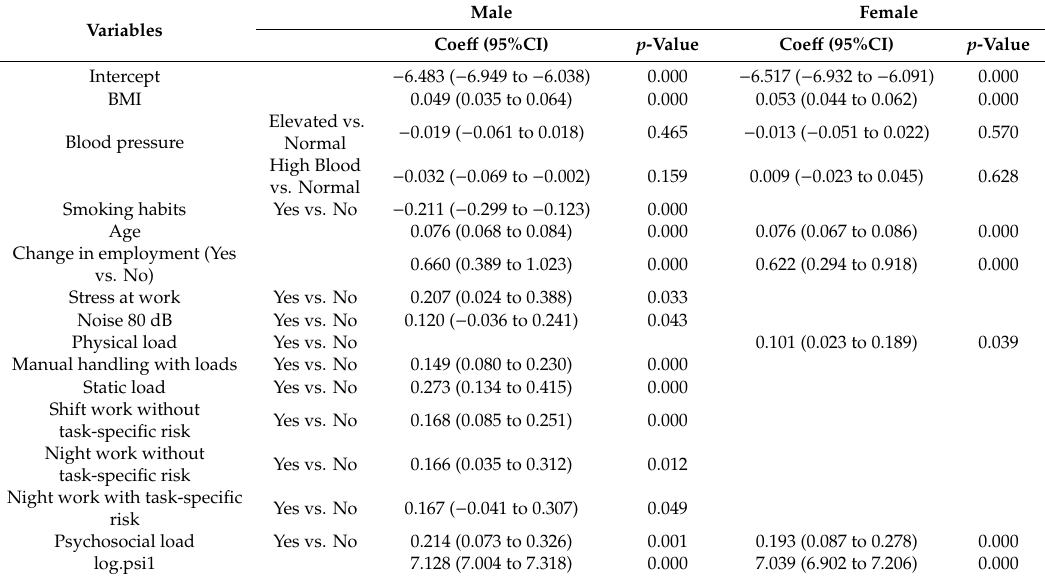
Table 4. Logistic regression model for being on medication for CVD by